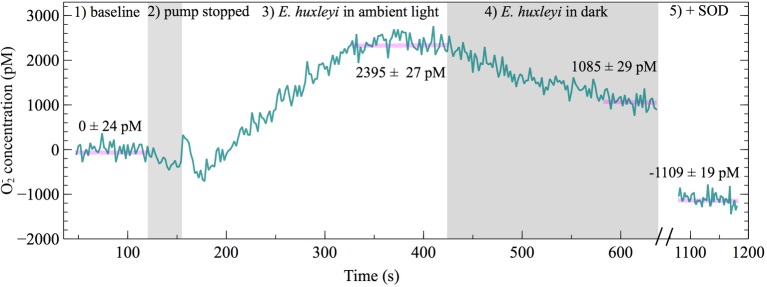
FeLume time-series of O2− measurements under different light conditions on day 2 of E. huxleyi growth (biological replicate B) split into five regions: (1) phosphate buffer solution and MCLA reagent baseline (which is subtracted from the biogenic O2− concentration in regions 3 and 4), (2) shaded region showing loading of E. huxleyi cells while the pump was stopped, (3) E. huxleyi in ambient light, (4) the second shaded region showing E. huxleyi in the dark, and (5) drawdown of the O2− signal below the baseline after addition of SOD (negative O2− concentrations account for SOD driven degradation of O2− originating from auto-oxidation of the MCLA reagent). The average ± SE of stable steady-state O2− concentration measurements are indicated by horizontal pink lines.